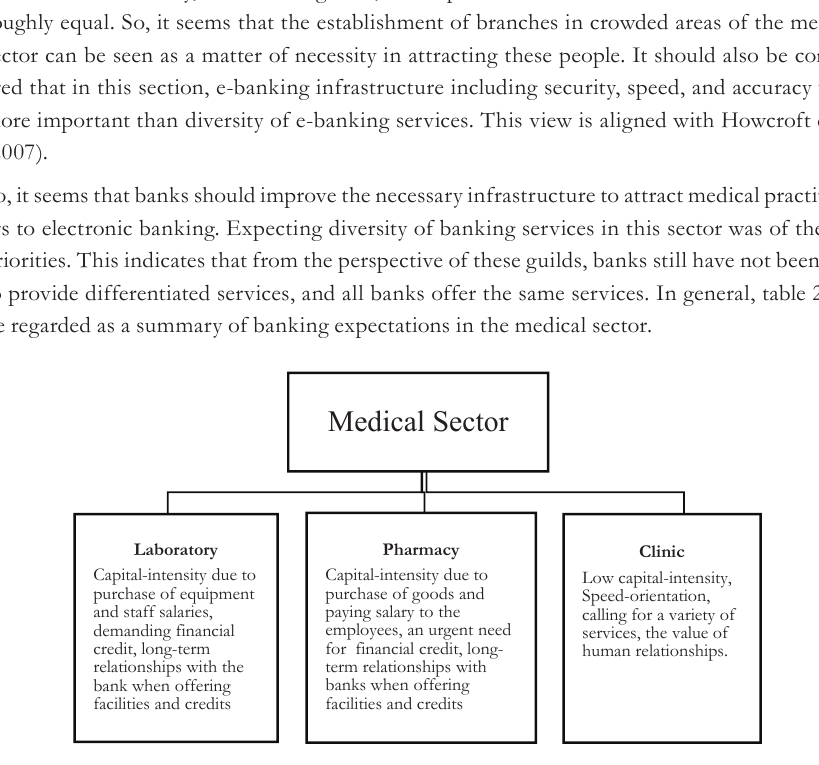
Fig. 2 - Expectation characteristics of guilds in the medical sector. (Source: